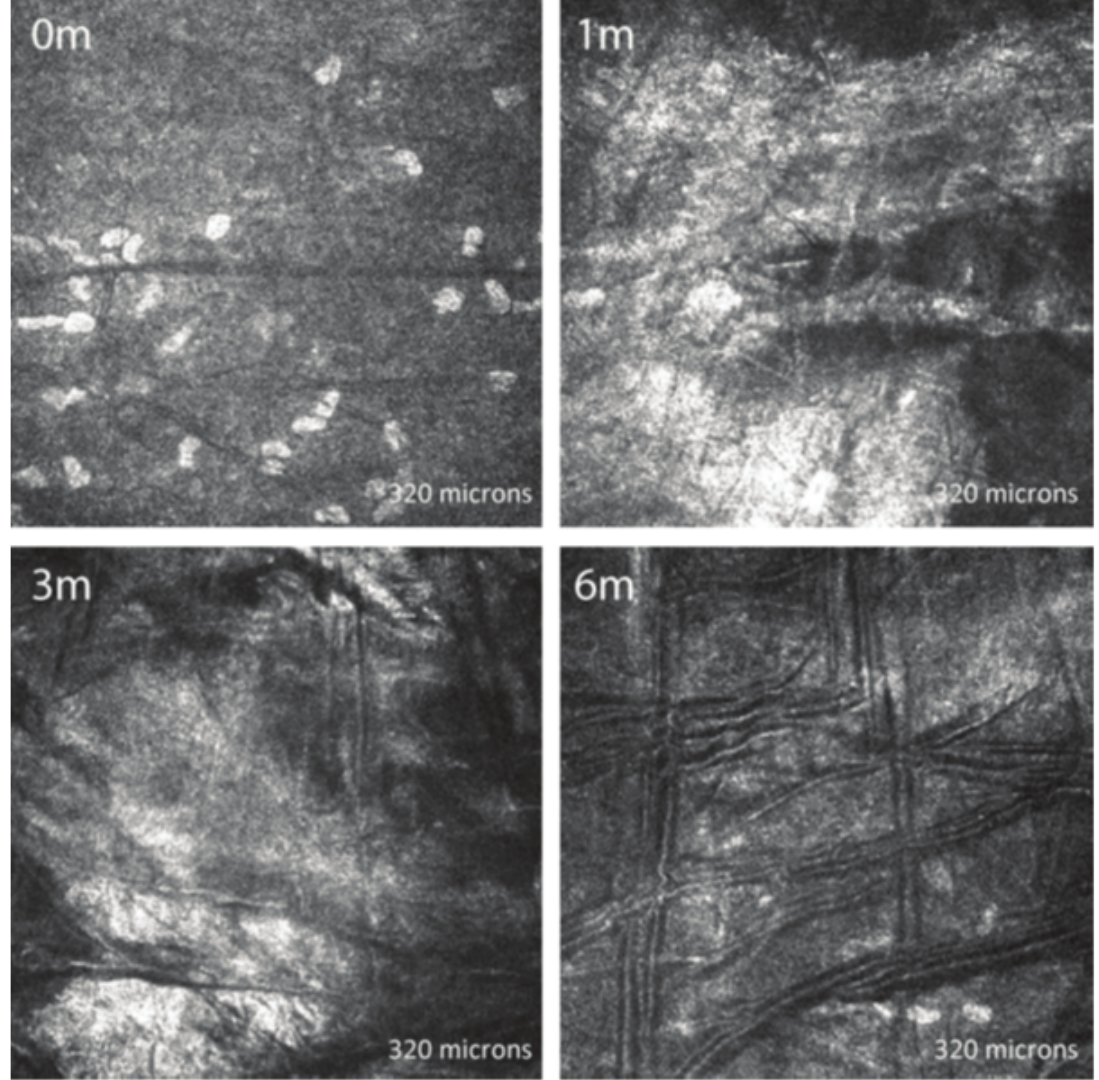
Figure 5. In vivo confocal microscopic images of the posterior stroma in a representative patient with posterior stromal apoptosis. Compared with the preoperative scan (0 m), a reduction in the number of keratocytes was observed at one month (1 m), three months (3 m), and six months (6 m).